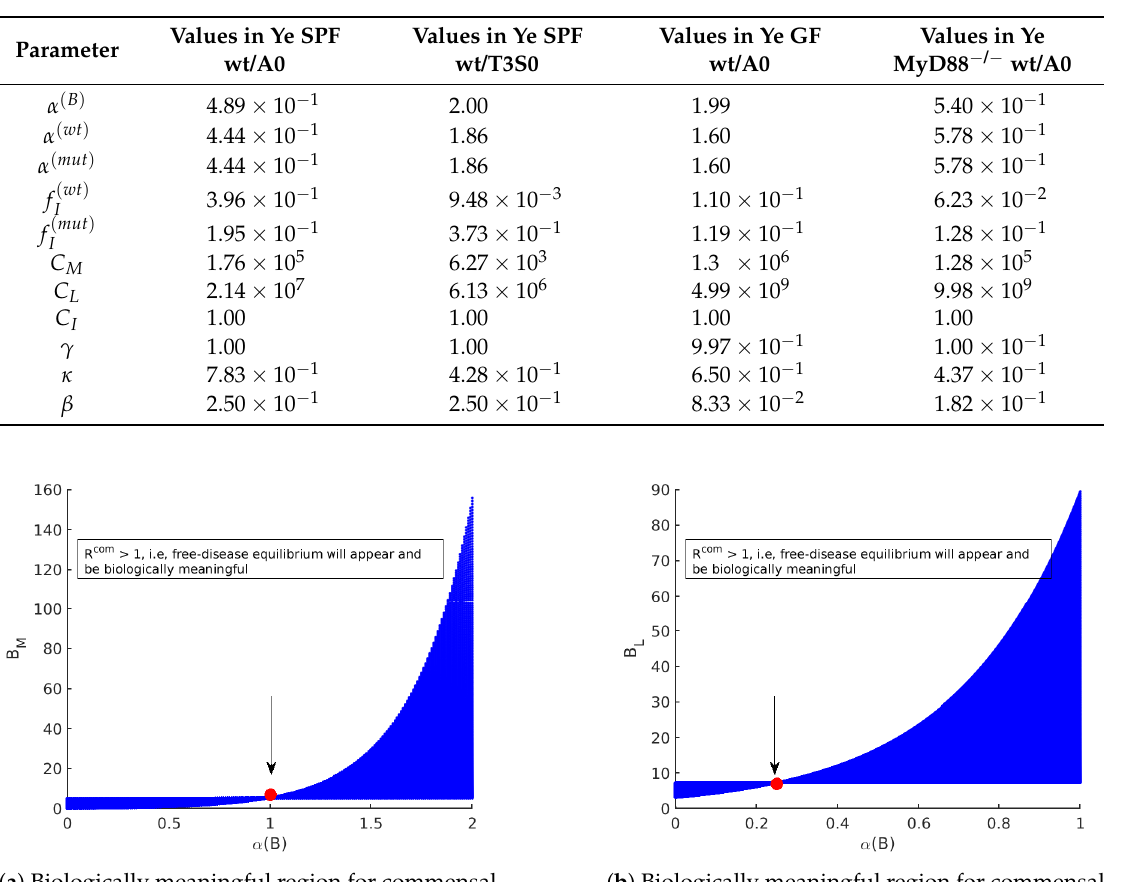
Table 3. Parameter values.